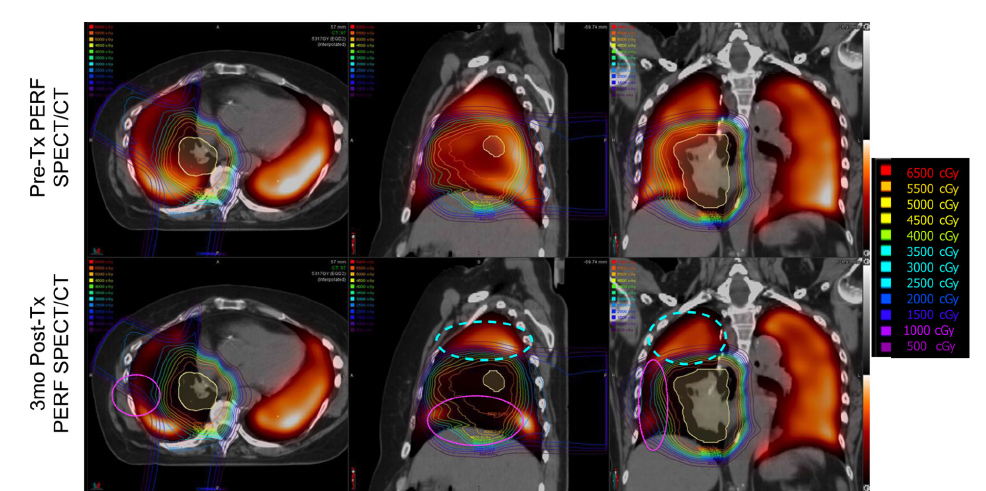
Figure 8. Taken from Thomas et al. [26]. Observed radiation dose–response on longitudinal perfusion SPECT/CT. ( Upper row ) Pre-treatment lung perfusion SPECT co-registered to planning CT and radiation isodose line rainbow overlay. ( Lower row ) Three-month post-treatment perfusion SPECT co-registered to planning CT and radiation isodose lines (rainbow overlay). SPECT window/level were normalized to out-of-field integral uptake. Regions within the treatment field show reductions in uptake that are correlated with radiation dose magnitude and spatial distribution. A dotted cyan oval is drawn to indicate a region that received low dose but did not experience perfusion decline. A magenta oval is drawn in another region that received low dose but did experience perfusion decline post-RT and is fed by an irradiated region. Reprinted with